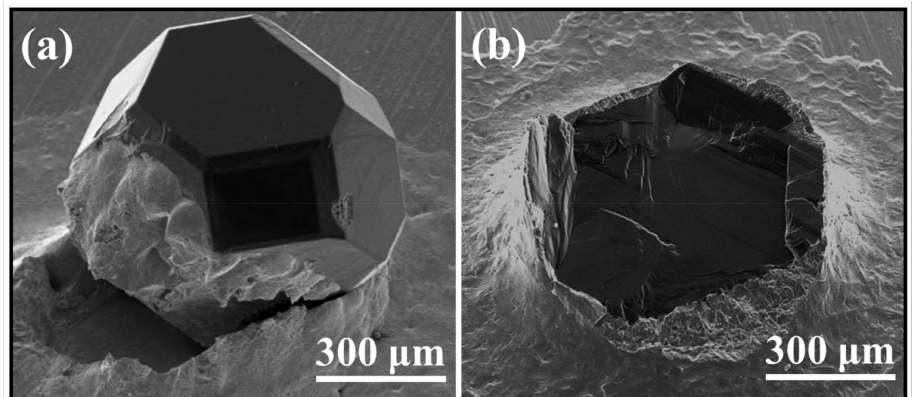
Figure 17. SEM images of the failed grits after single grit test when brazed with ( a ) Ag-Cu-Ti brazing alloys and ( b ) Ni-Cr brazing alloys. Reprinted with permission from Ref. [75]. Copyright 2017, Elsevier.